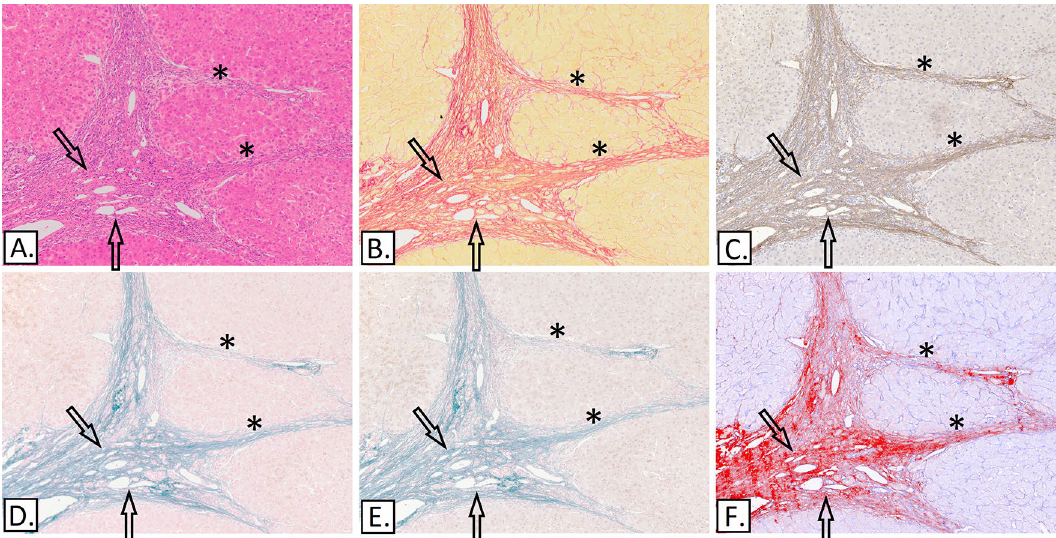
Figure 8. Alcohol related cirrhosis. ( A ) H&E. ( B ) Picro-Sirius red. ( C ) IHC-Elastin, (ab9519). ( D ) Victoria Blue. ( E ) Modified Victoria blue—no oxidation step. ( F ) IHC-Collagen I (ab6308) in red & collagen III (ab7778), spectrally unmixed channels from Nuance camera + software. Portal tract remnant (arrows) and fibrous septa (asterisks) containing both collagen I and mature elastic fibres as demonstrated by the lack of differential staining between the standard Victoria blue (D) and the modified Victoria blue method (E).